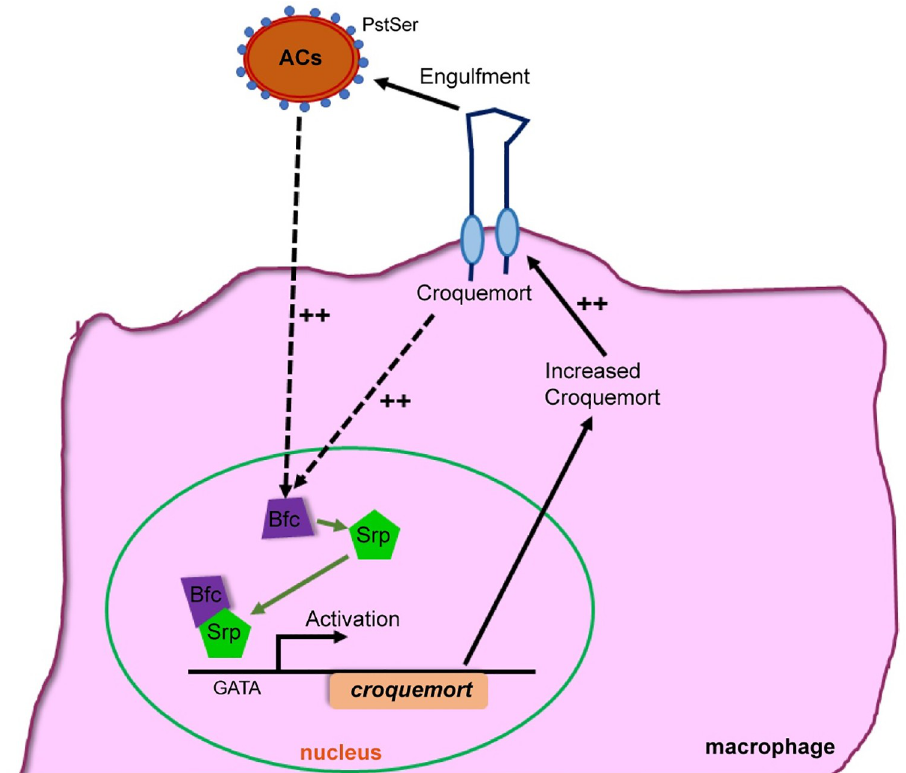
Fig 7. The AC-induced Crq expression is regulated by the Bfc-Srp pathway. The basal Bfc expression remains at relatively low levels in the absence of ACs. However, in the presence of ACs, during efferocytosis, bfc expression is transcriptionally upregulated earlier than crq , and Bfc interacts with the GATA factor Srp to facilitate latter’s binding to the crq promoter. In turn, increased Crq levels likely enhance the ability of macrophages to engulf ACs and lead to the upregulated expression of Bfc via a positive feedback